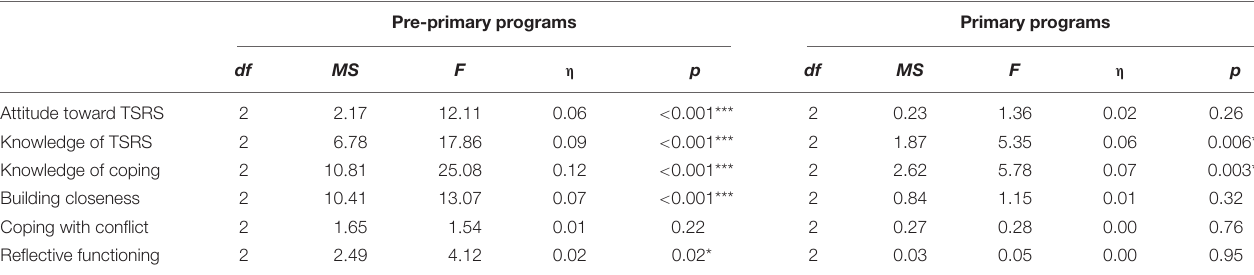
TABLE 13 | ANOVA results for pre-primary and primary